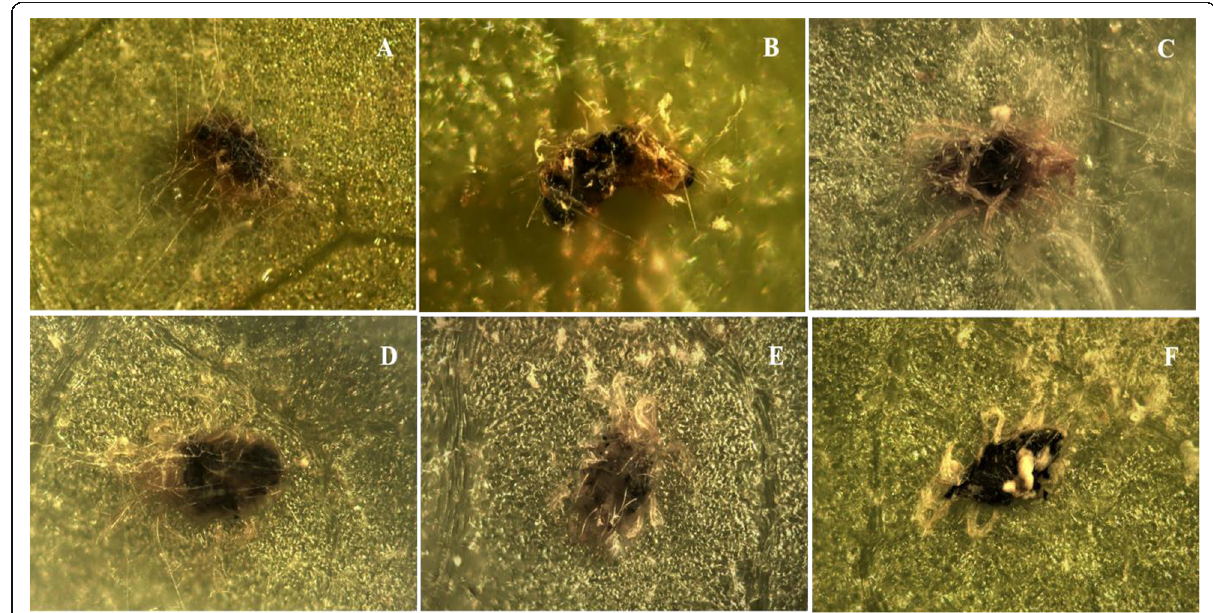
Fig. 3 Tetranychus urticae individuals infected with BGF14 isolate of Beauveria bassiana after 3 days ( a ), 5 days ( b ), and 7 days ( c ) and BCA32 isolate after 3 days ( d ), 5 days ( e ), and 7 days ( f